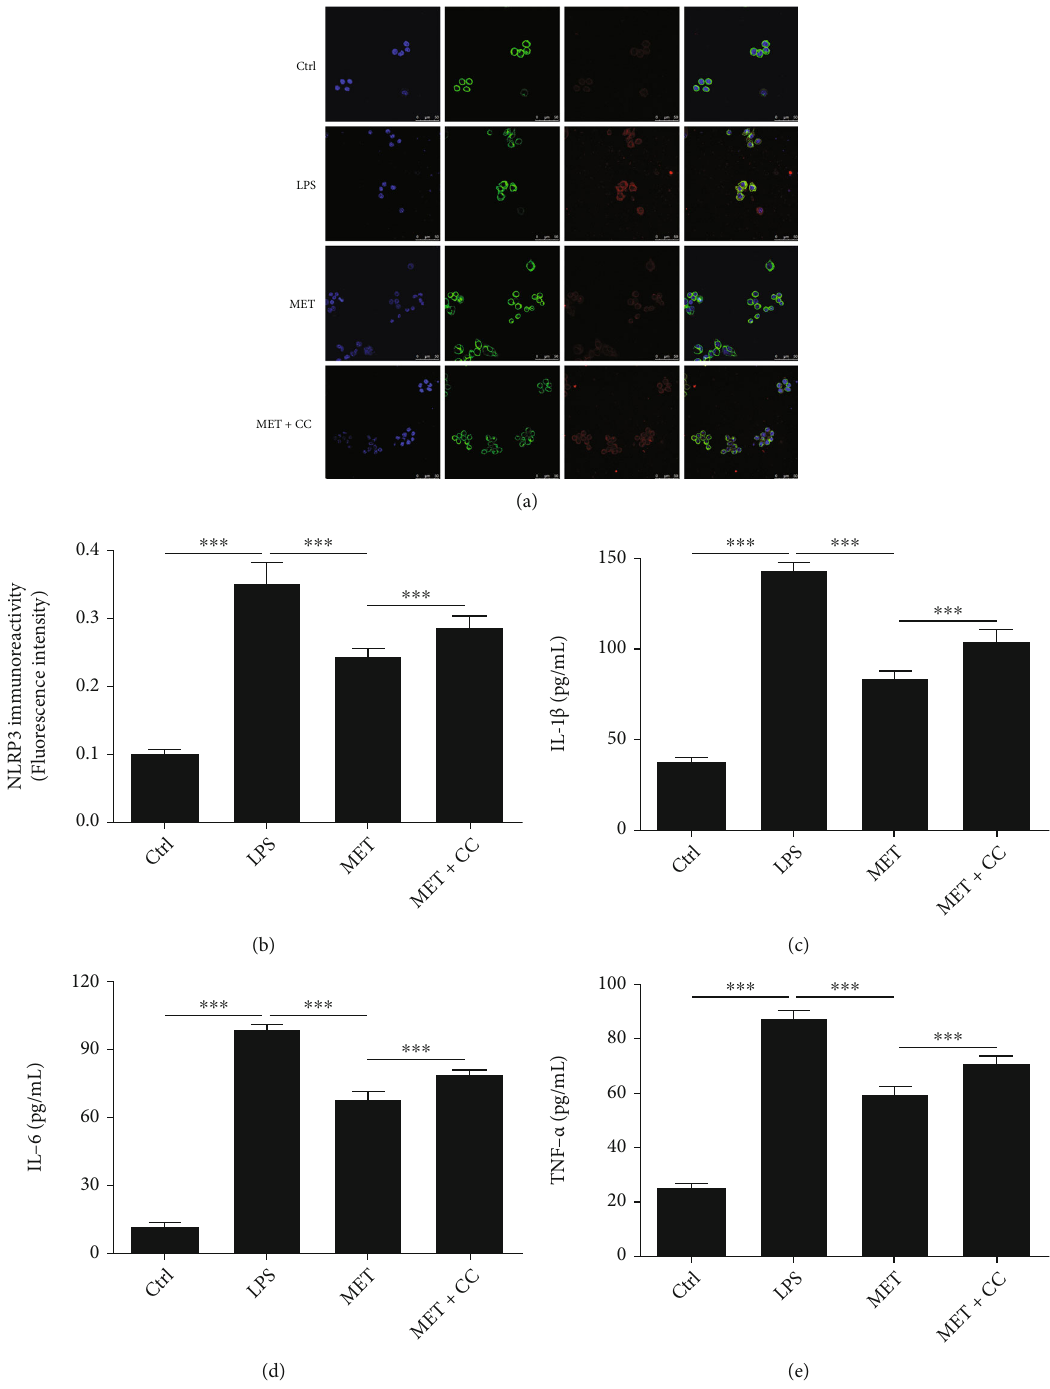
Figure 3: Metformin inhibits NLRP3 activation as well as proin fl ammatory factor expression in RAW 264.7 cells. (a, b) Immuno fl uorescence staining intensity of antibodies targeting NLRP3 in RAW 264.7 cells was determined using immuno fl uorescence analysis. Scale bars represent 50 μ m. ∗∗∗ P < 0 : 001 , n = 3 . (c – e) ELISA was used to detect the expression of IL-1 β , IL-6, and TNF- α in the supernatant of RAW 264.7 cells from each group. All data represent the mean ± SD , ∗∗∗ P < 0 : 001 , n = 3 cell growth, development, apoptosis, and other biological puts power into neuroprotective e ff ects on some CNS dis- functions [13, 23, 24]. AMPK is the main regulator of cellu- eases and neurodegenerative diseases [7, 8, 11]. MET acti- lar energy producing and the interaction between metabo- vates AMPK through STK11 (also experienced as LKB1), lism and tumors [25, 26]. which has to do with multiple signaling pathways and a ff ects